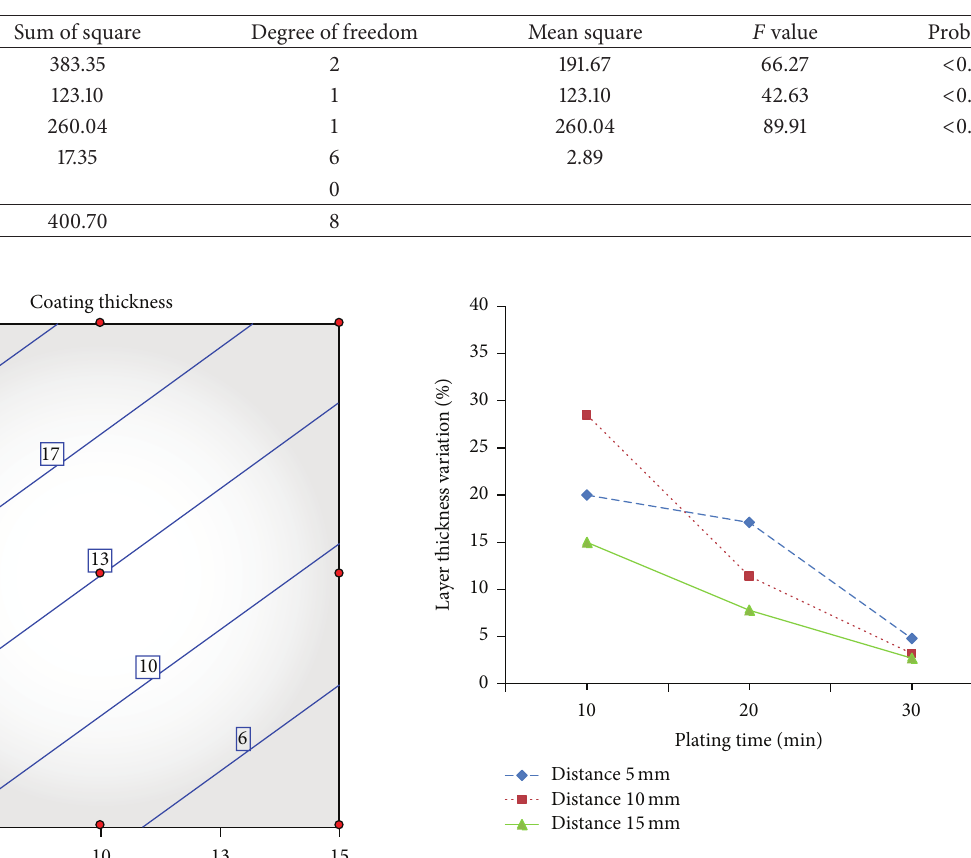
Table 2: Analysis of variance of the coating thickness model.